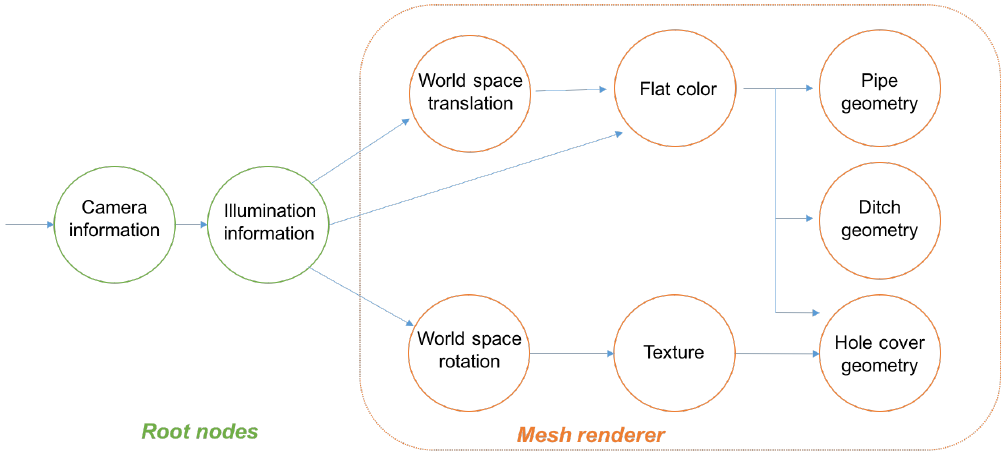
Figure 13. Direct acyclic graph for an example where 3 geometry symbols (pipe, ditch and cover) require 7 symbol